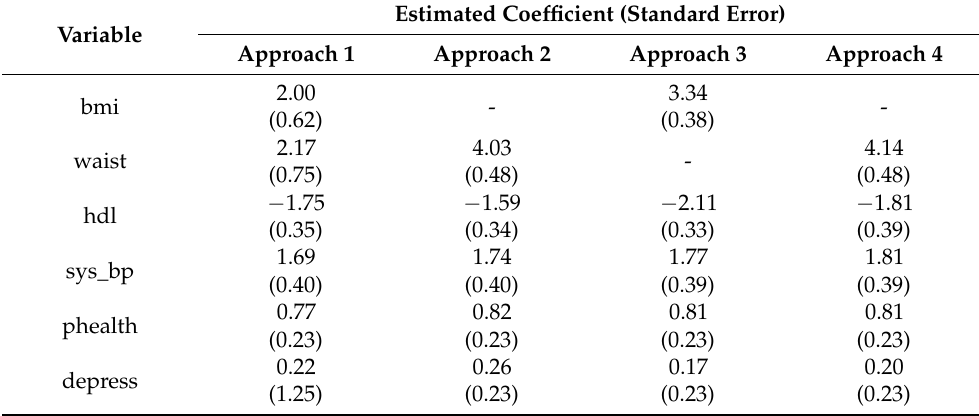
Table 6. Coefficients and performance of the predictive model of T2D onset obtained in approach 1 (standard RFE-Borda method with both BMI and waist circumference), approach 2 (proposed algorithm, the model with waist is shown), approach 3 (standard RFE-Borda method with BMI only), approach 4 (standard RFE-Borda method with waist circumference